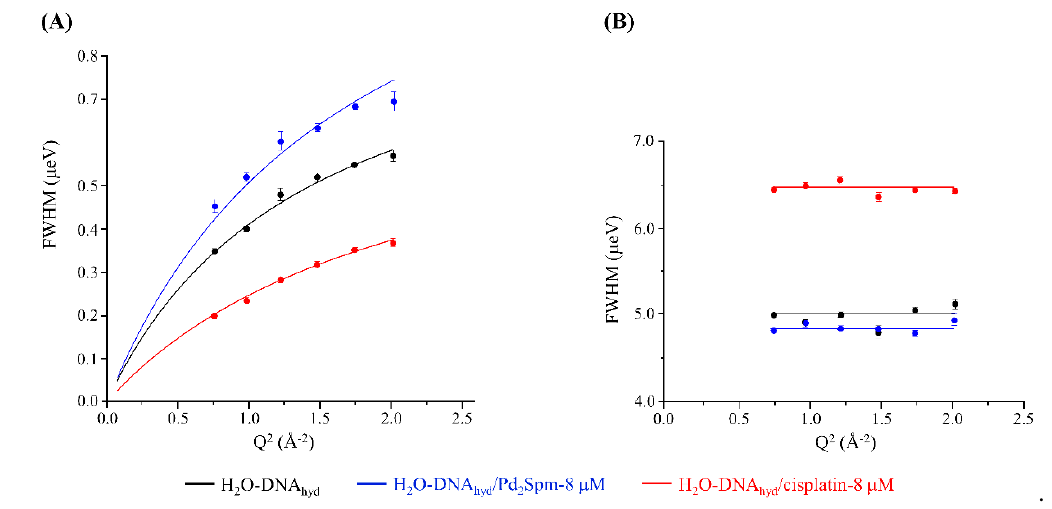
Figure 8. Variation of the full widths at half-maximum (FWHM) with Q 2 for untreated, and Pd 2 Spm- and cisplatin-treated H 2 O-DNA hyd (at 8 μ M and 298 K): Lorentzian functions representing the slow backbone dynamics (Q-dependent) ( A ) and the water motions within the spine of hydration (Q-independent) ( B ). Error bars throughout the text represent one standard deviation unless defined otherwise.